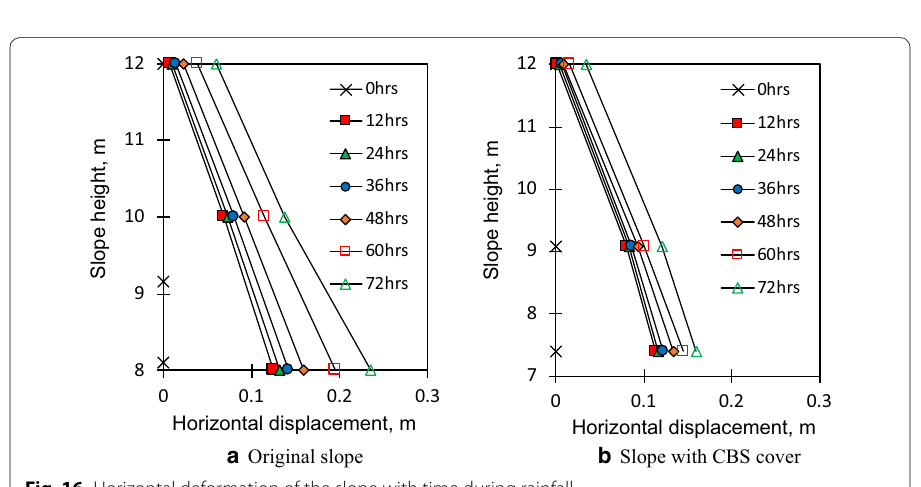
Fig. 16 Horizontal deformation of the slope with time during